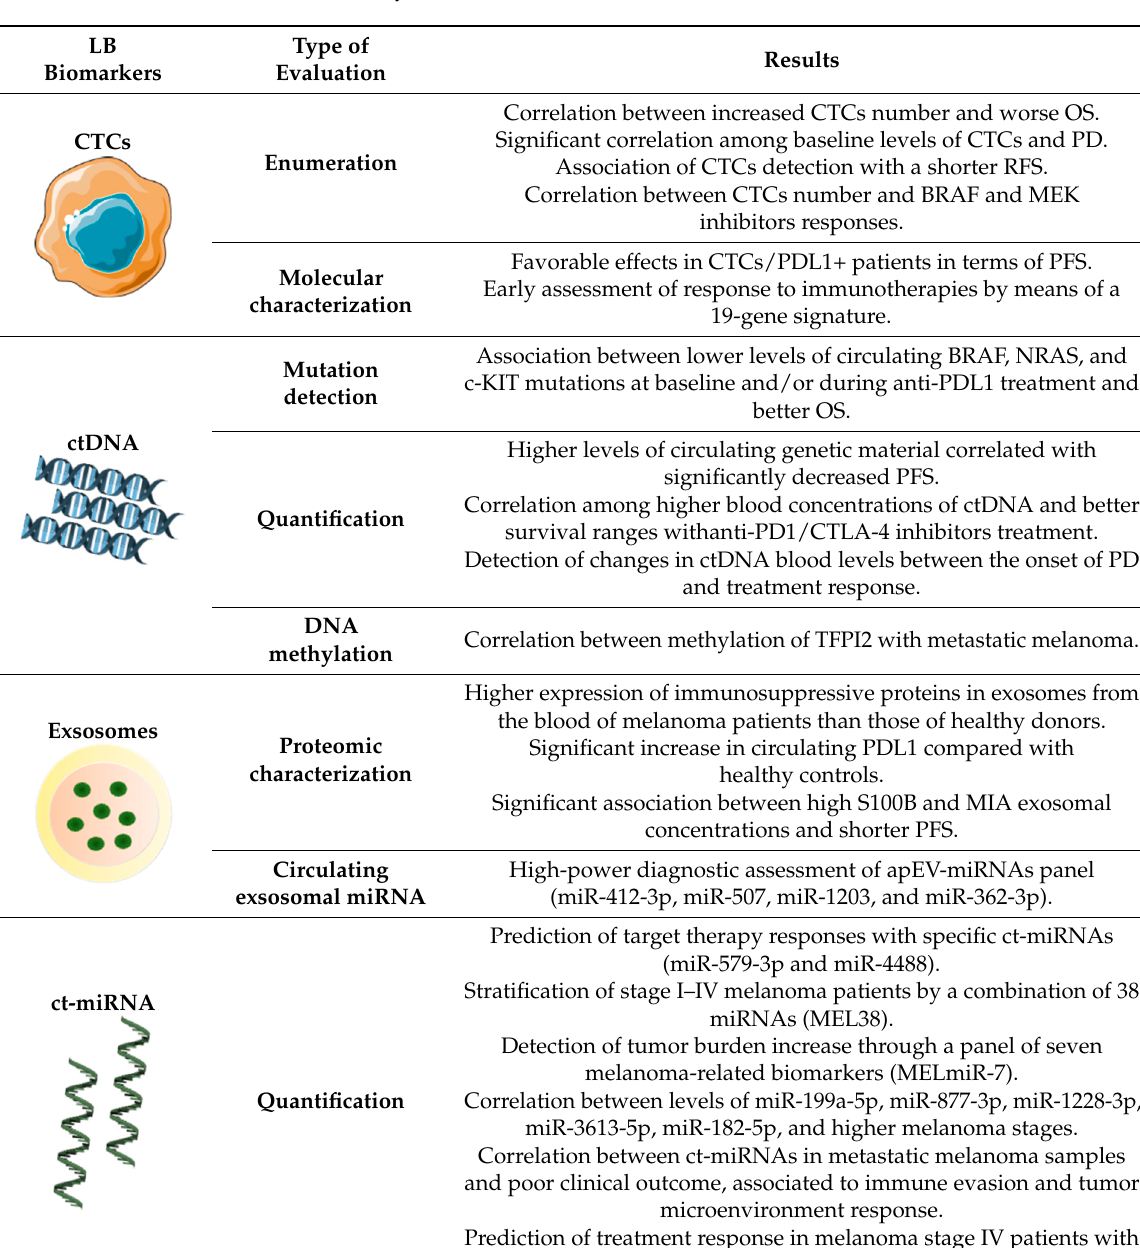
Table 1. Most important tumor alterations investigable in circulating biomarkers by sequential LB analysis.